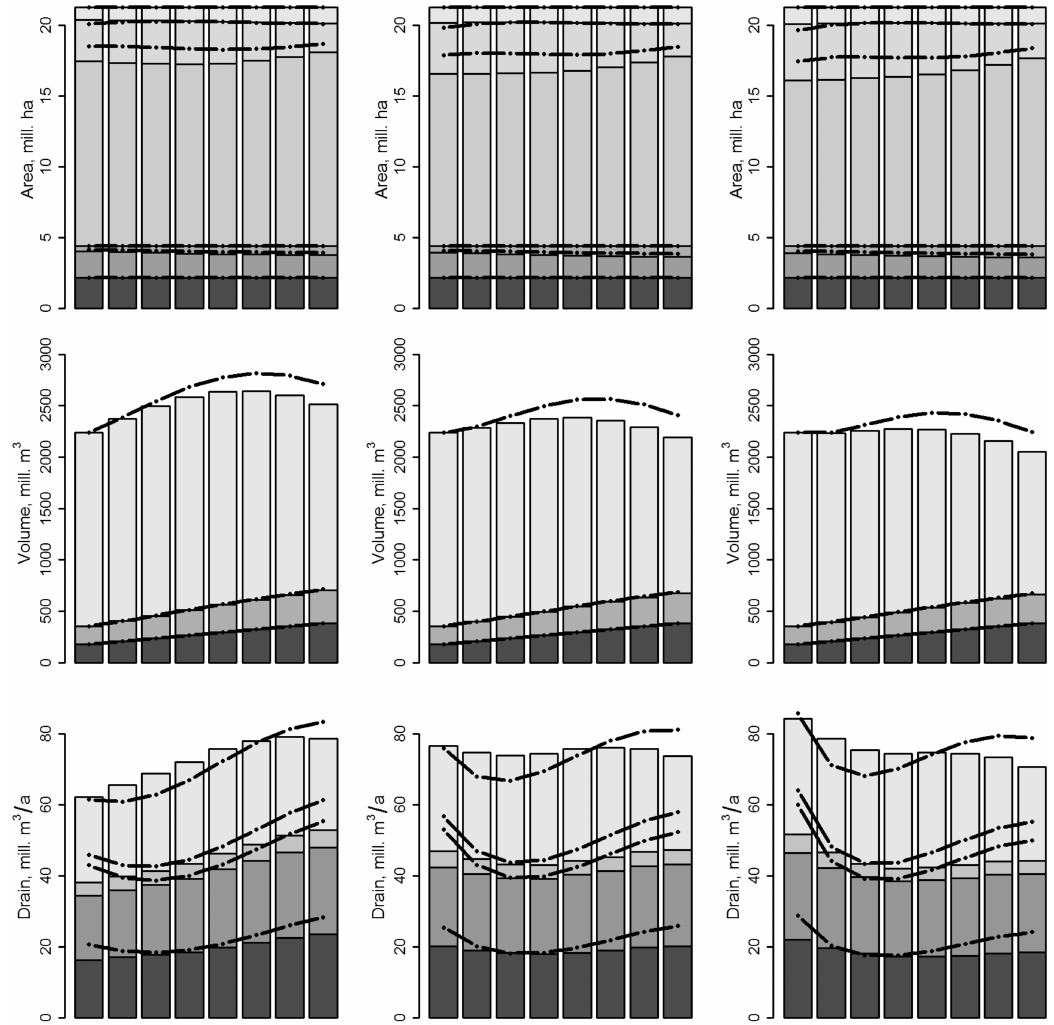
Figure 7. Land use, growing stock and timber assortment drain, when the activity probabilities were set in the beginning of the simulation . Refer to the caption of Figure 6 for the interpretation of the